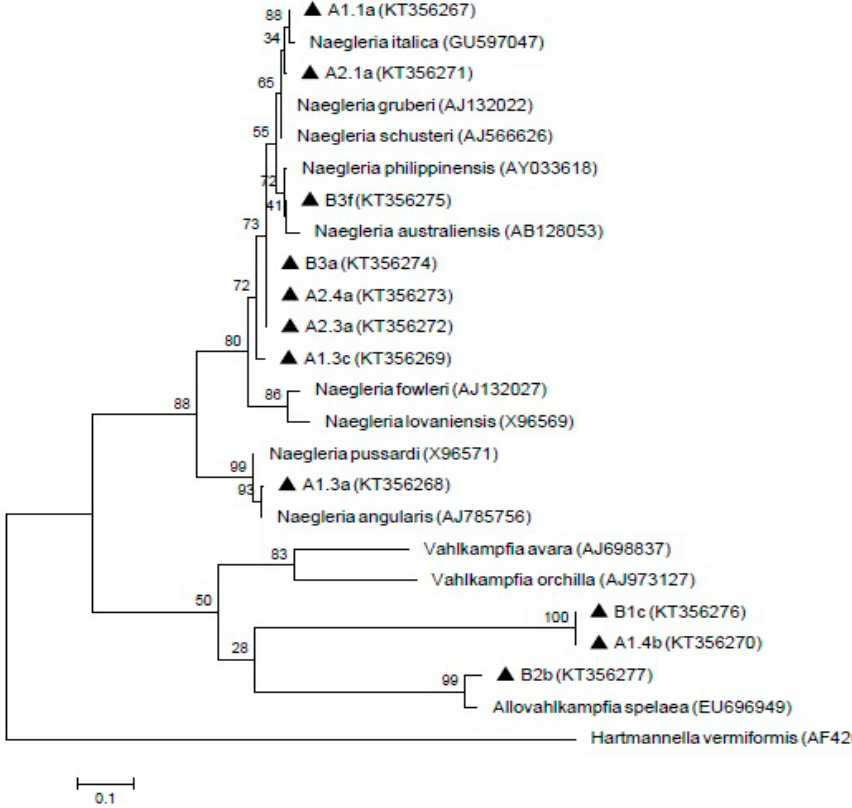
Figure 4. Maximum-likelihood tree depicting the relationships between isolated and reference strains of Naegleria, Vahlkampfia and Allovahlkampfia . The numbers on branch points depict the values of 1000 bootstrap replicates. GenBank accession numbers for reference sequences are indicated at the end of the species